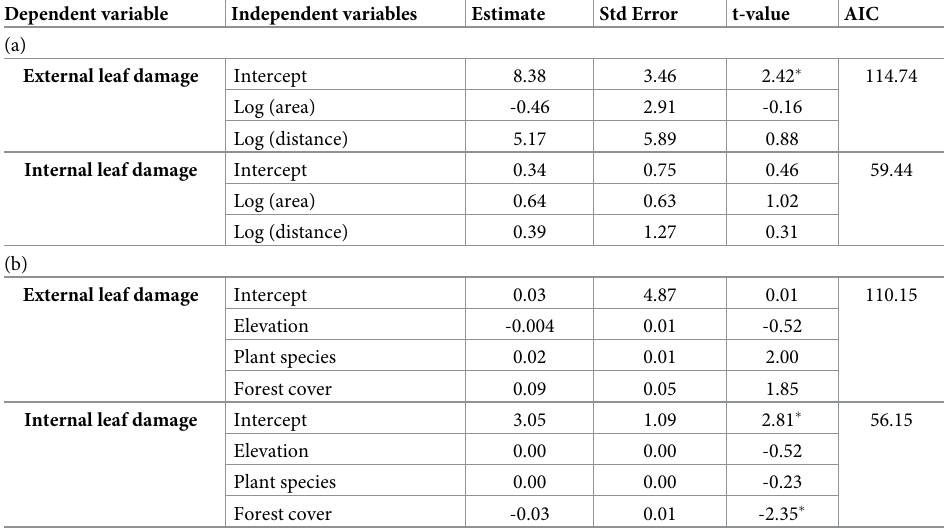
Table 2. Generalized linear regression for external and internal feeding guilds using geography (a) and habitat diversity and plant resources (b). Std Error, Standard Error, AIC, Akaike Information Criteria. � P < 0.0.5.